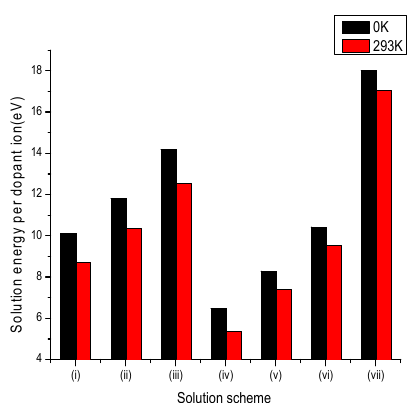
Figure 2. Bar chart of solution energies vs. solution schemes for trivalent dopant (V 3+ ) at the Li and Nb sites, considering the first neighbours in relation to the c axis.